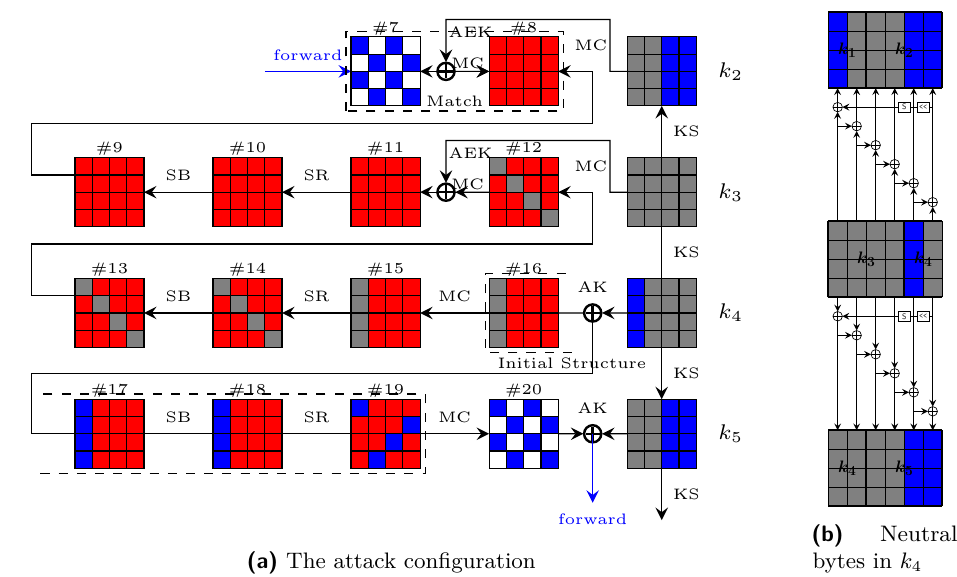
Figure 8: Introducing free bytes in the key to improve the 7-round preimage attack on AES -192 hashing mode